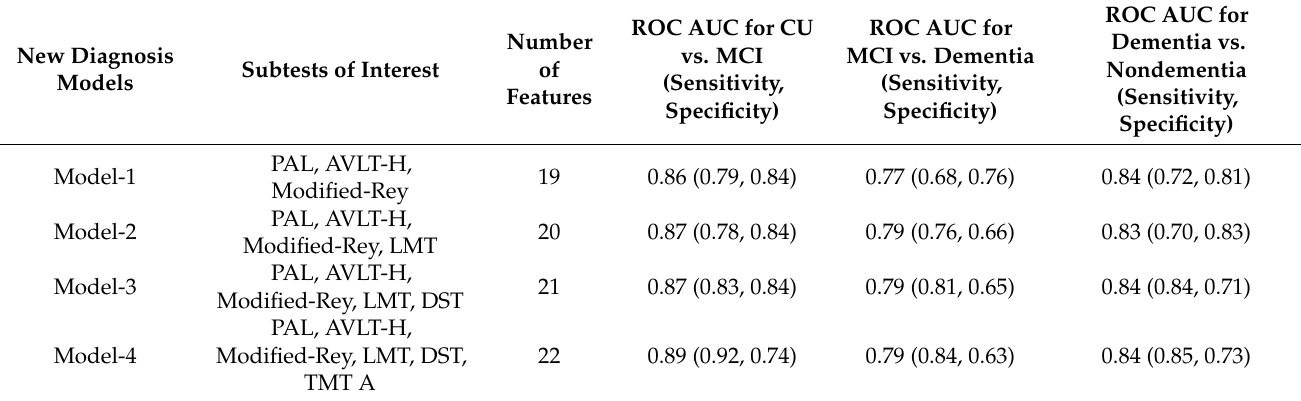
Table 3. Performance ofthe fournew RFdiagnosis models onthe classificationof CU,MCI, and